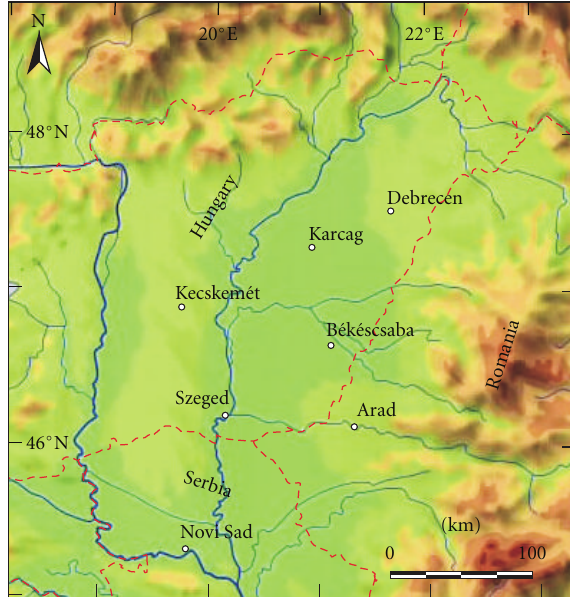
Figure 1: Locations of Novi Sad and the investigated cities in [8] with the relief map [9] of the Great Hungarian Plain and country borders (dashed